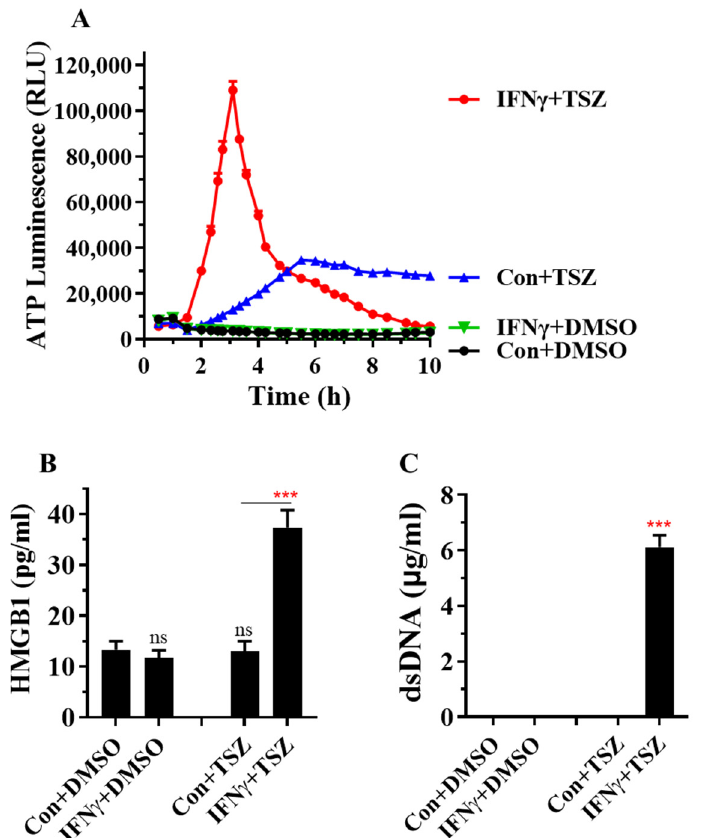
Figure 5. IFN γ greatly accelerates the release of DAMPs from AECs. ( A ) Mouse primary AECs were incubated with PBS (Con.) or IFN γ (50 ng/mL) for 24 h, then treated for 0 to 10 h with DMSO or necroptosis inducer TSZ. The release of ATP from AECs was continuously monitored by using RealTime-Glo™ extracellular ATP assay kits, and the levels of ATP luminescence are presented as means ± SE (n = 8). ( B , C ) Mouse primary AECs were incubated with PBS (Con.) or IFN γ (50 ng/mL) for 24 h, then treated for 6 h with DMSO or necroptosis inducer TSZ. The levels of HMGB1 and dsDNA in cell supernatant were determined and are presented as means ± SE (n = 4). Student’s t test was performed in ( B , C ). *** p < 0.001 versus control (Con.) in each treatment group. NS, no significance.